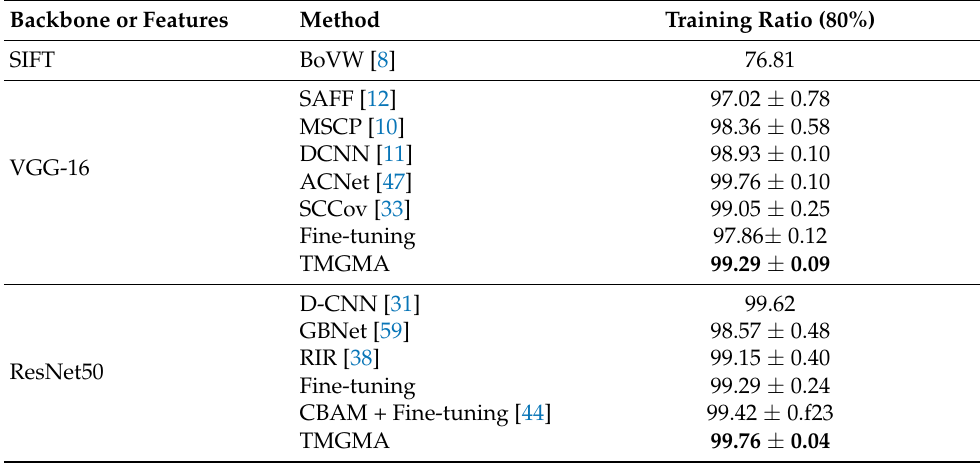
Table 1. Classification accuracies (%) of the proposed TMGMA and other methods on the UC Merced dataset.